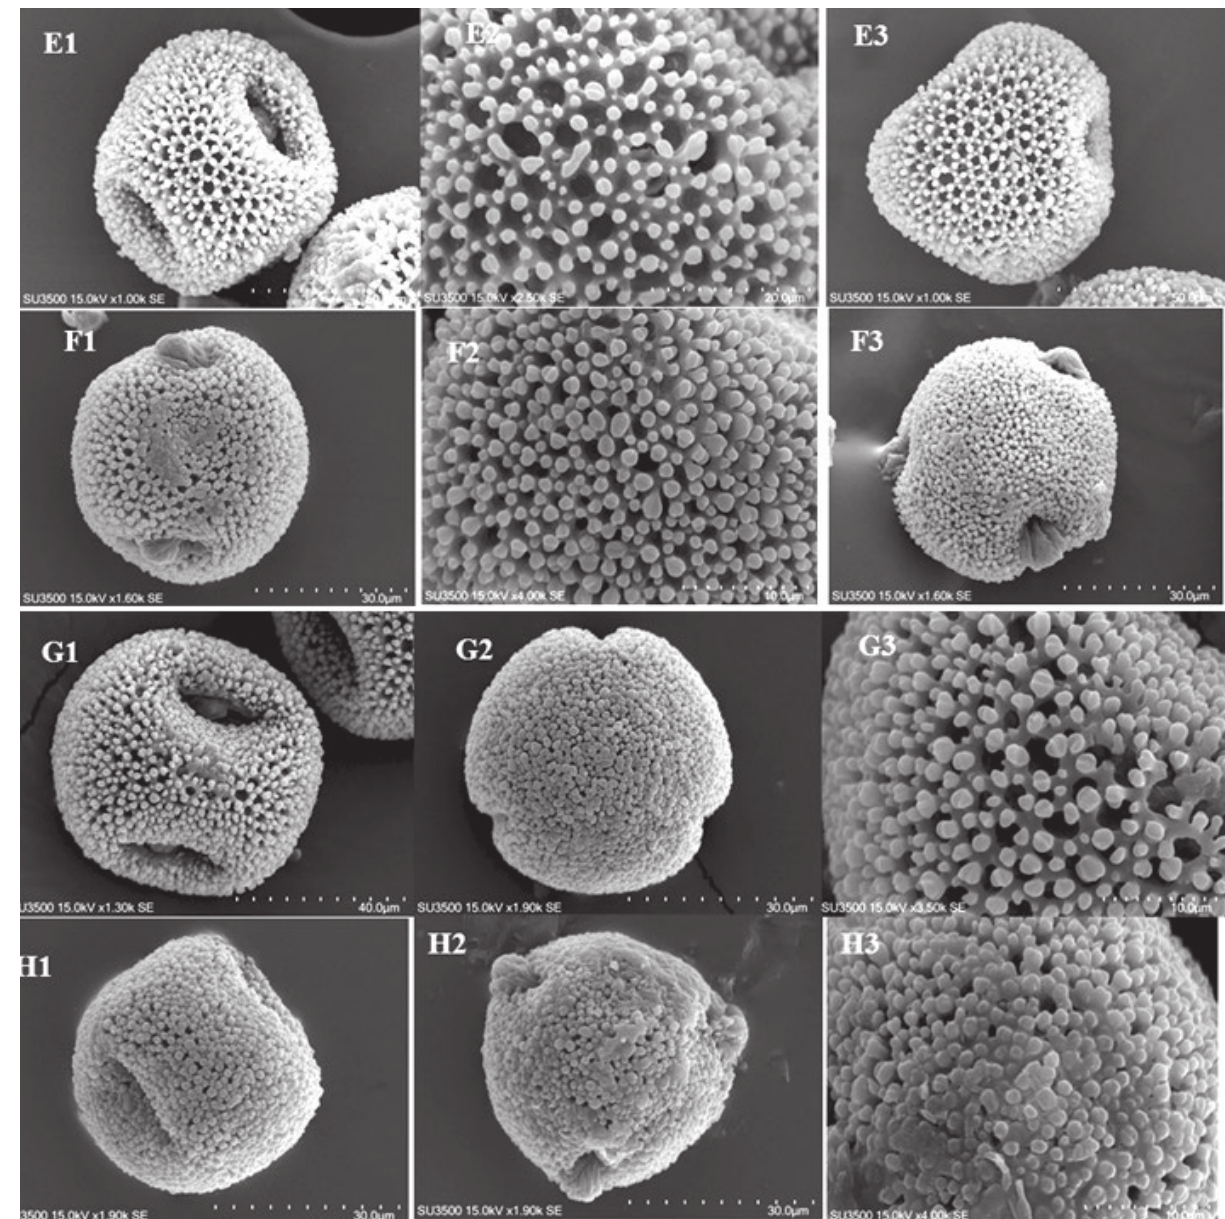
Figure 3. Pollen micrographs of Geranium species: E1-E3: G. sylvaticum, F1-F3: G. molle, G1-G3: G. pyrenaicum , H1-H3: G. pusillum ; E1, F1, G1, H1 – equatorial view; E2, F2, G2, H2 - polar view; E3, F3, G3, H3 -exine